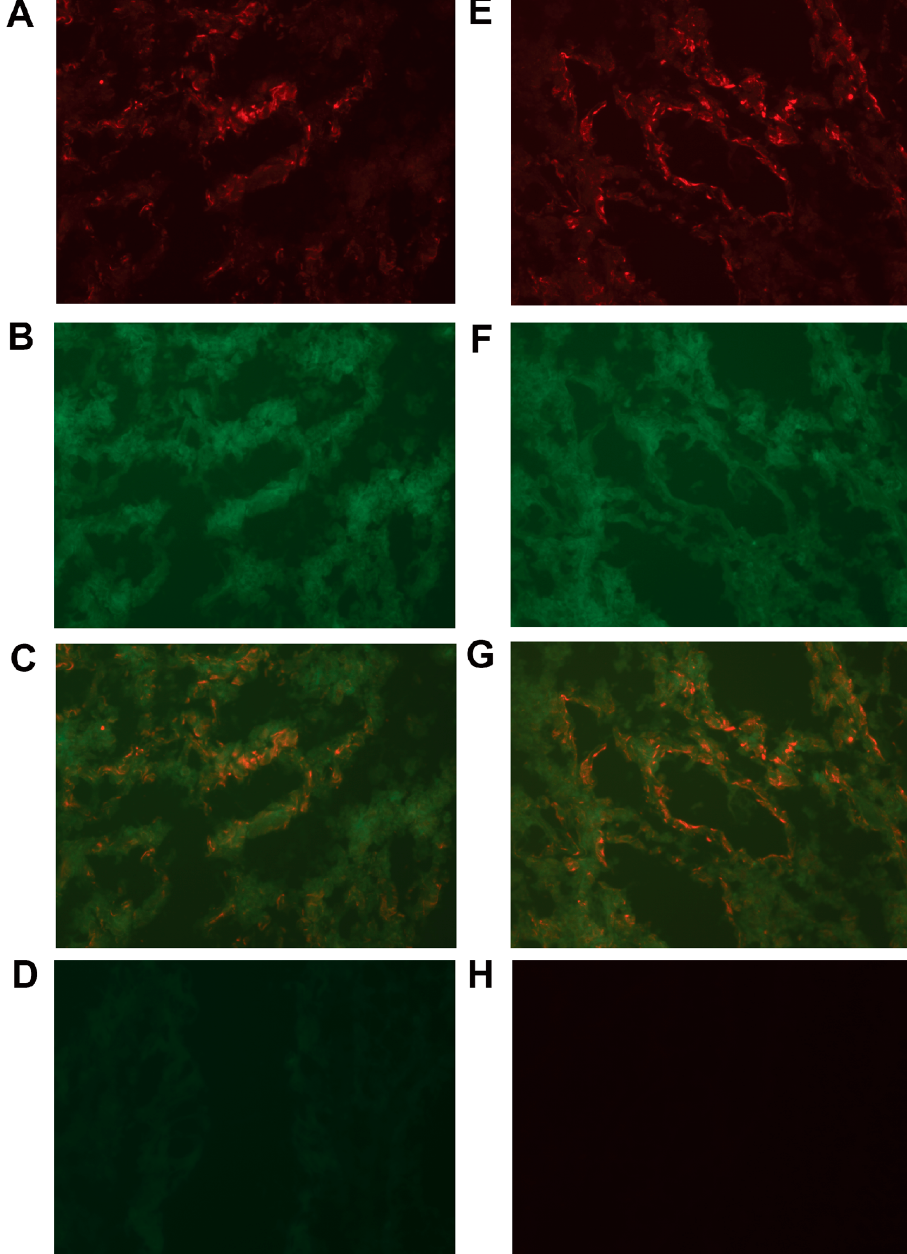
Figure 5. Two-color immunofluorescence staining of primary colon cancer tissue with anti-CXCL14 and BerEP4, and anti-CXCL16 and BerEP4. ( A ) Anti-CXCL14, ( E ) Anti-CXCL16 both red color. ( B , F ) BerEP4 mAb, green color. ( C , G ) Overlays giving yellow color of double-stained areas. ( D ) FITC-conjugated mouse IgG; negative control for BerEP4. ( H ) Rabbit IgG; negative control for anti-CXCL14 and anti-CXCL16. Original magnification: ×